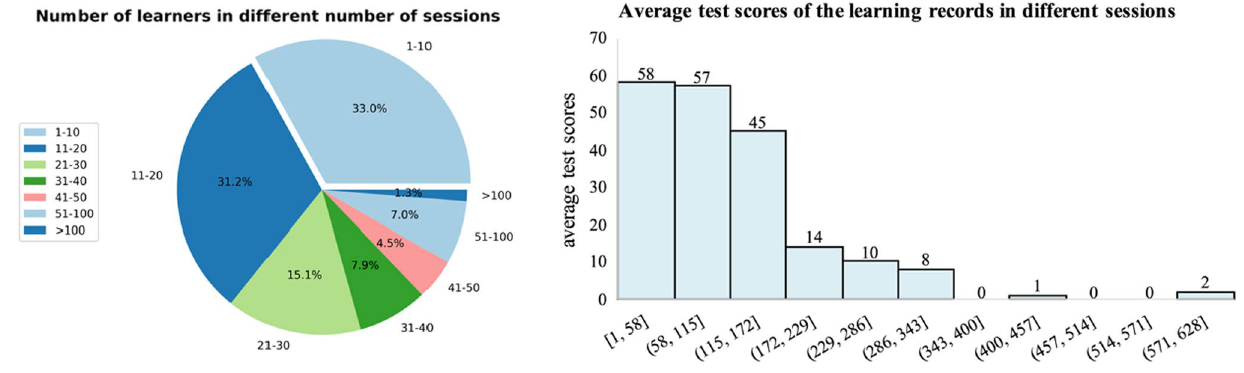
Fig. 6 Left: number of learners in different number of sessions. Right: average test scores of learners over different session